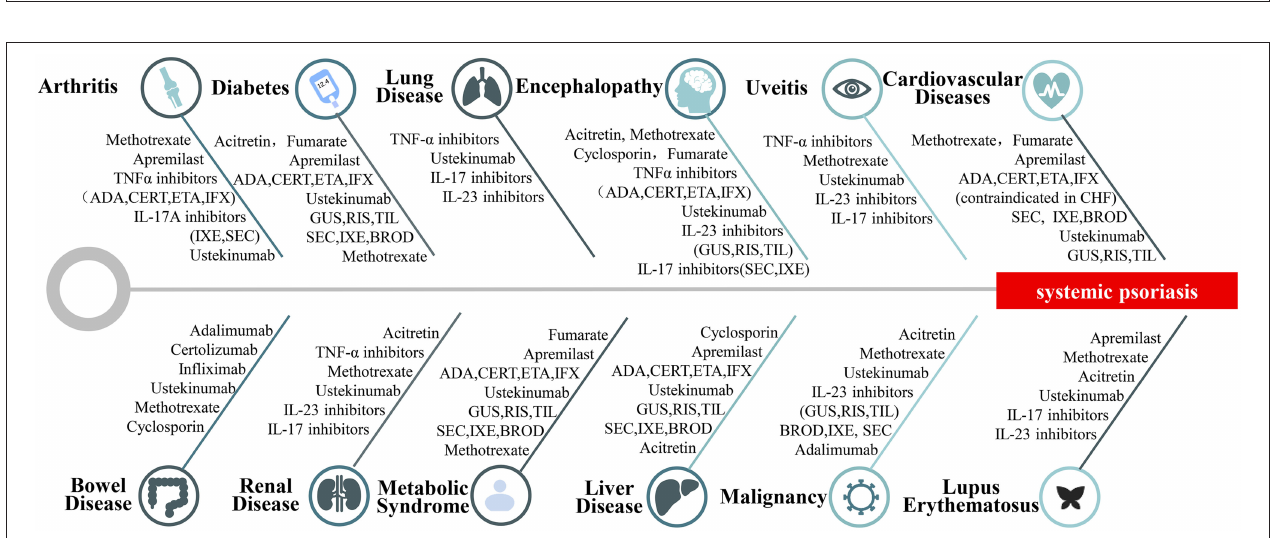
FIGURE 2 | Therapies for systemic psoriasis. Selection of treatments for different types of systemic psoriasis includes psoriatic arthritis, psoriasis with diabetes, psoriasis with pulmonary disease, psoriasis with brain diseases, psoriasis with uveitis, psoriasis with cardiovascular disease, psoriasis with bowel disease, psoriasis with nephropathy, psoriasis with metabolic syndrome, psoriasis with liver disease, psoriasis with malignancy, psoriasis with lupus erythematosus.